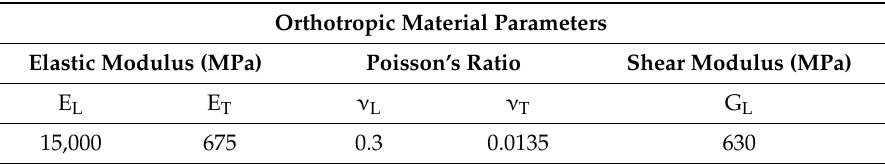
Table 2. Estimated transverse isotropy properties of bamboo.